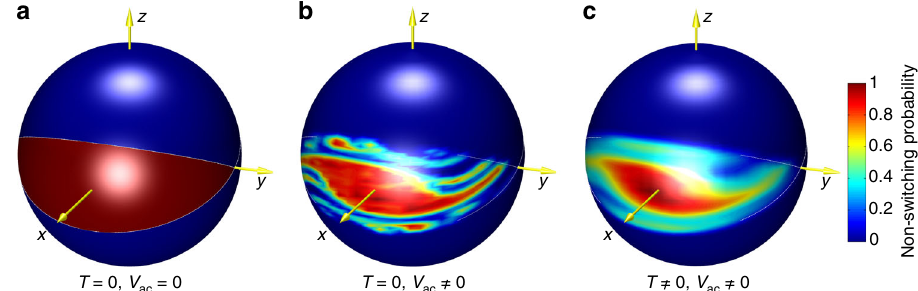
Fig. 5 Visualizing chaos. Directional map of probability of magnetization initially within the x > 0 potential well to remain within this well after 5 periods of alternating spin torque drive. Red color marks the initial direction of magnetization resulting in magnetization staying within the well, while blue color marks initial magnetization direction resulting in escape from the well after 5 periods of the drive. a At zero temperature ( T = 0) and in the absence of spin torque, any initial direction of magnetization within the well inde fi nitely remains within the well. b At zero temperature and alternating spin torque exceeding the threshold value, the fractal structure of escaping and capturing lobes within the well near the separatrices is apparent. Colors intermediate between red and blue appear as a result of coarse grained averaging of the fractal lobe structure over a small but fi nite solid angle. It is clear from this fi gure that chaotic dynamics induced by alternating spin torque decreases the basin of stability to a region in the center of the well, thereby reducing the effective energy barrier between the two wells. c At room temperature and spin torque drive exceeding the threshold value, the fractal lobe structure of the well is blurred by thermal fl uctuations but the chaos-induced erosion of the basin of stability is still apparent